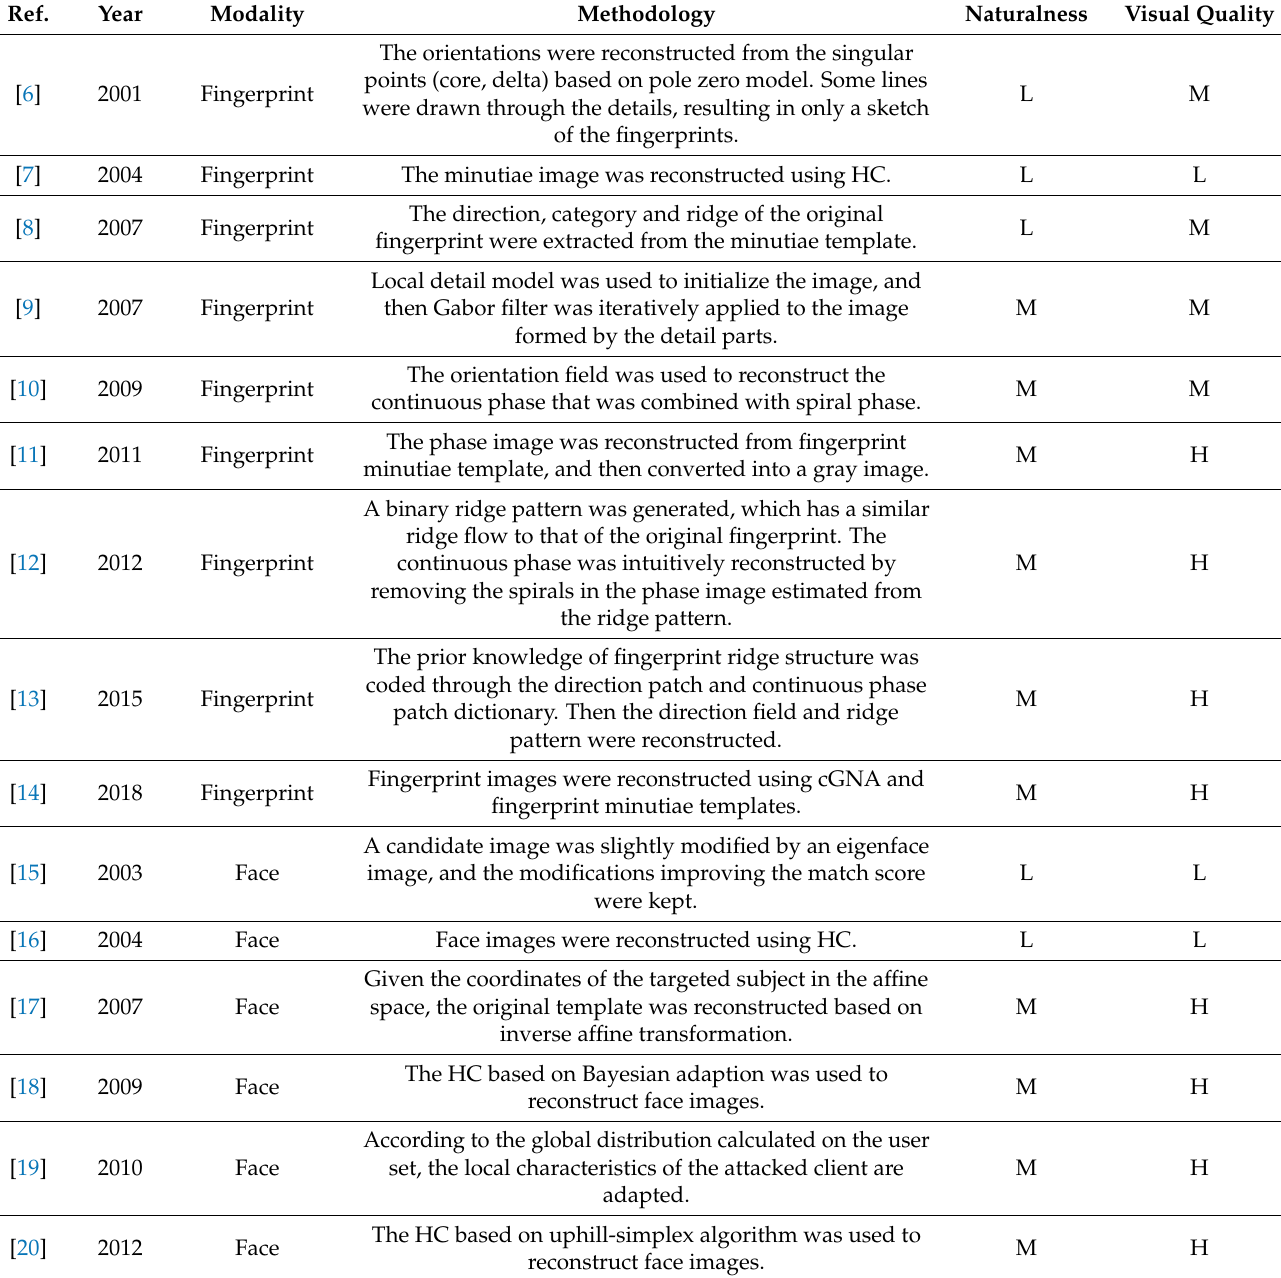
Table 1. Comparison of the reconstruction attacks in biometric systems (L, M, and H denote low, medium, and high,